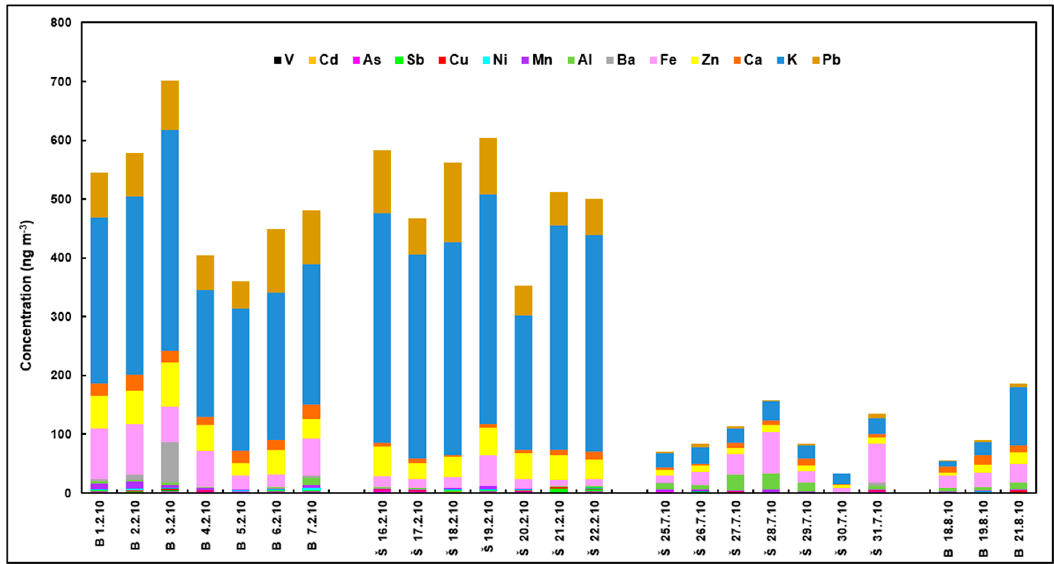
Figure 3. Daily variations in the concentrations of elements in the PM 1 aerosols in Brno and Šlapanice in 2010.